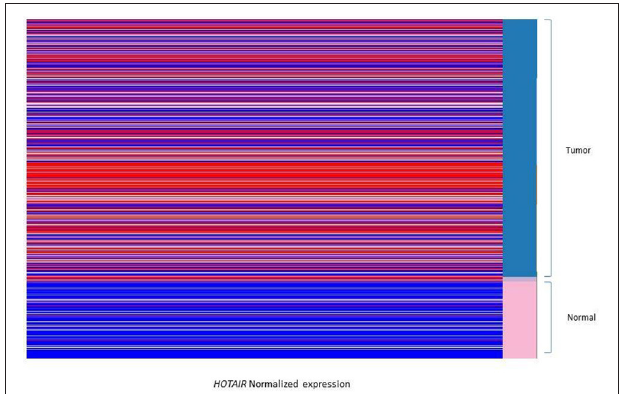
FIGURE 1 | Heatmap displays the comparison between the HOTAIR expression of breast tumors and solid normal tissues. The data heatmap displays the normalized gene expression in red (Z > 0) and blue color (Z < 0). The HOTAIR is overexpressed in breast tumor tissues (A part of the tissues are shown as blue subgroup in right column) compared to normal tissues (shown as pink subgroup in right column). Data is derived from Cancer genome browser database.